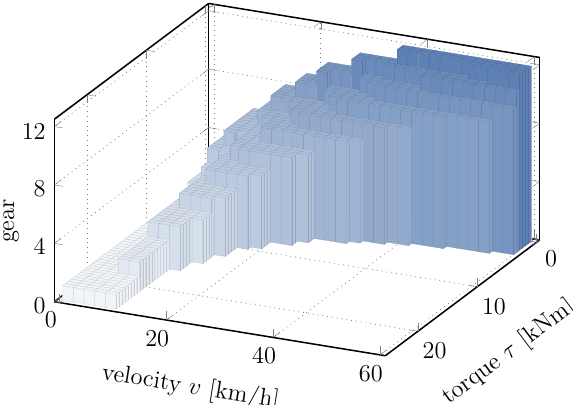
Figure 3. Optimal gears to achieve lowest brake specific fuel consumption over velocity and de- sired torque output of the combustion engine. The empty area exceeds the engines maximum power output.